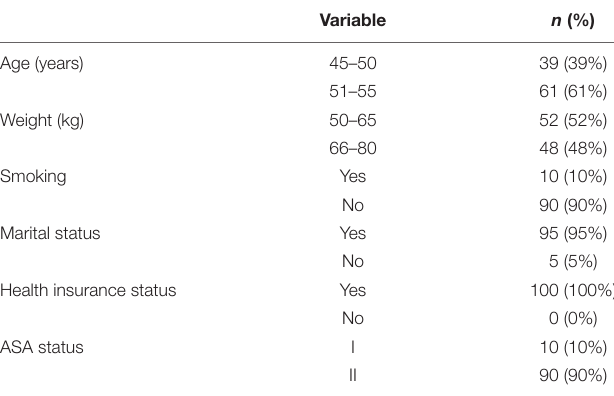
TABLE 1 | Descriptions of general demographic features of the study